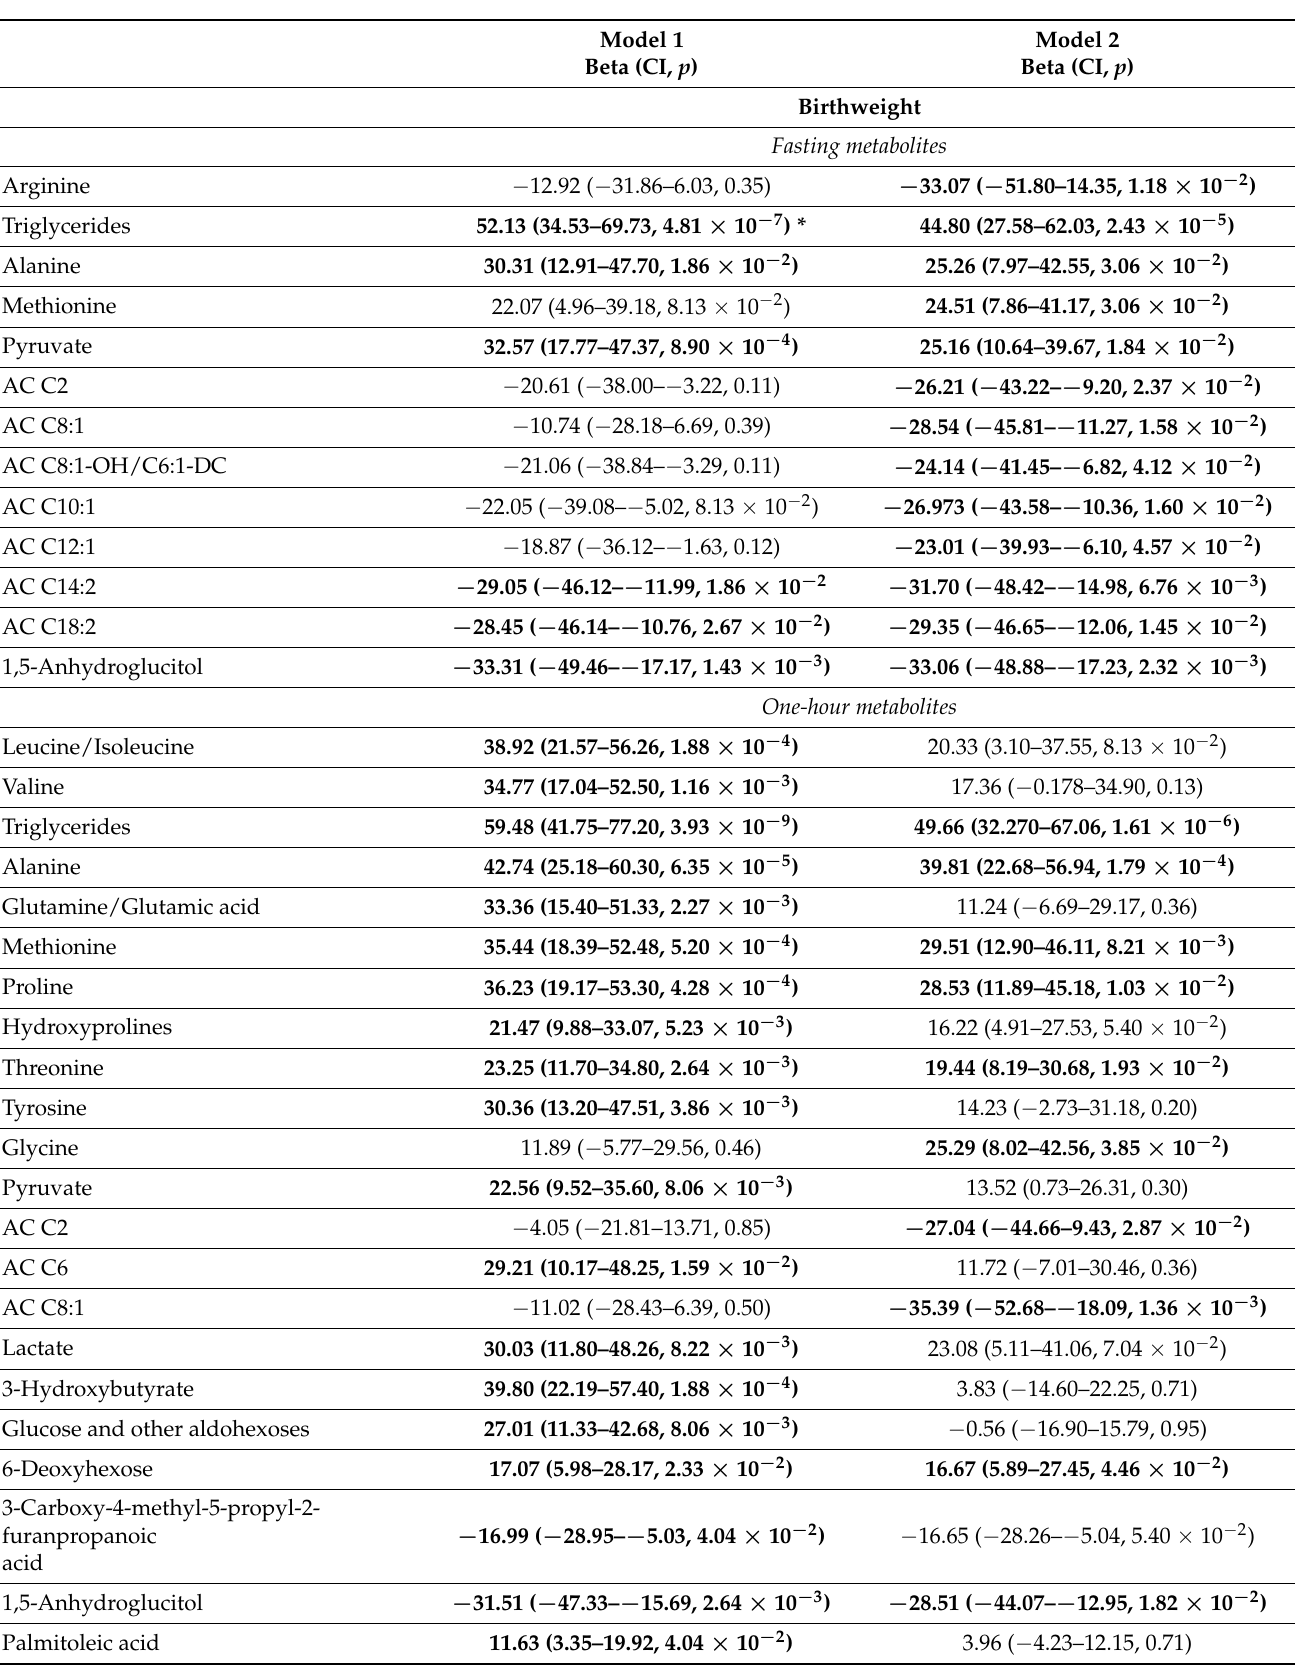
Table 2. Associations of maternal metabolites with newborn